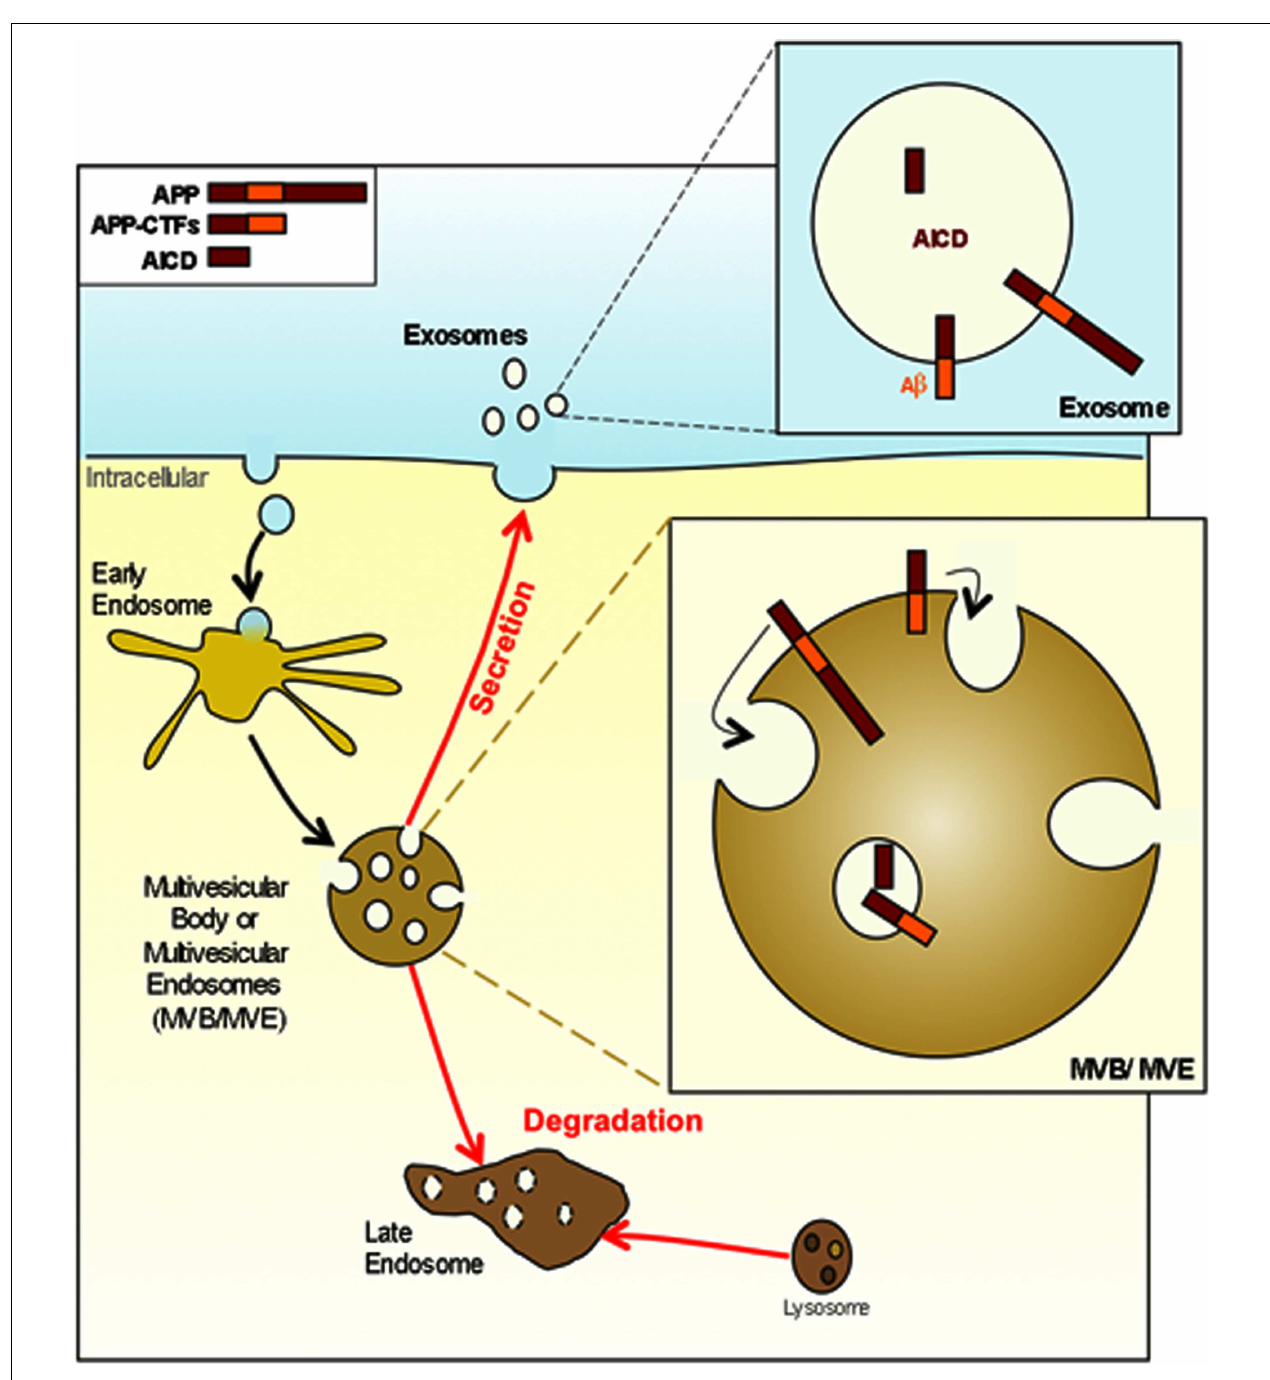
metabolites can either be degraded after the fusion of MVB with lysosomes or can be released in the extracellular space in association with exosomes consecutively to the fusion of MVB with the plasma